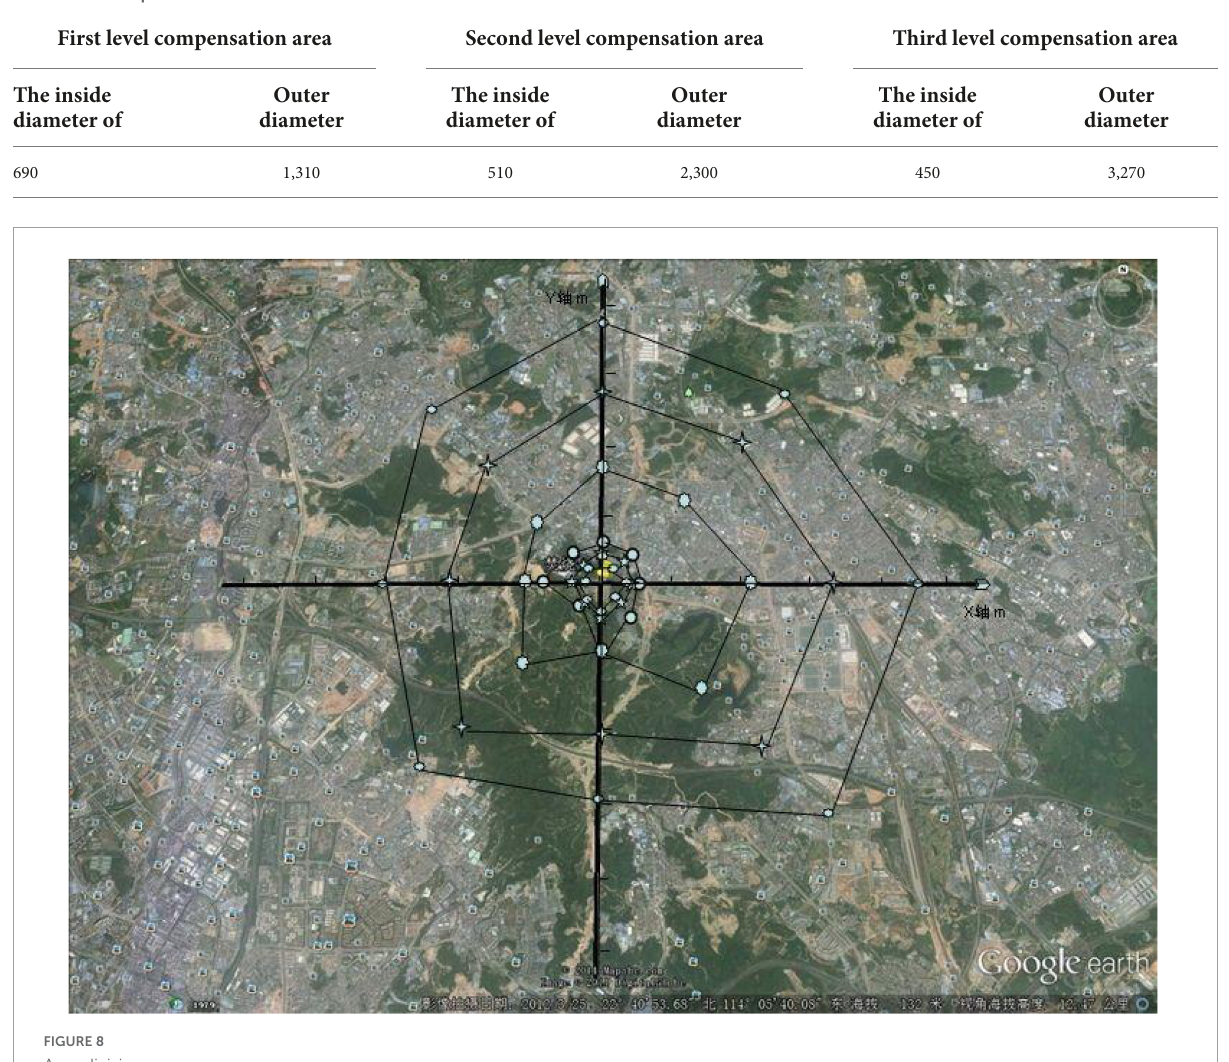
FIGURE8 Area division map.